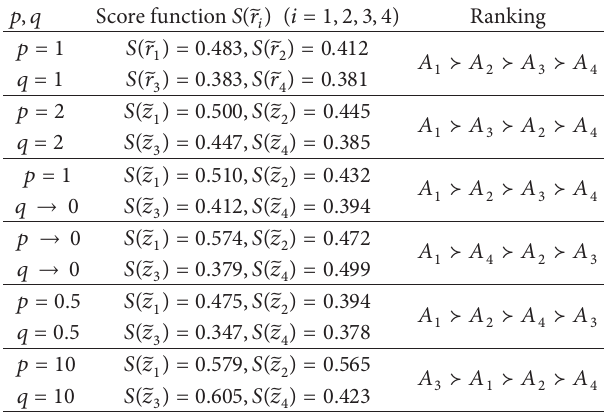
Table 2: Ordering of the alternatives by utilizing the different 𝑝, 𝑞 in ILWB 𝑝,𝑞